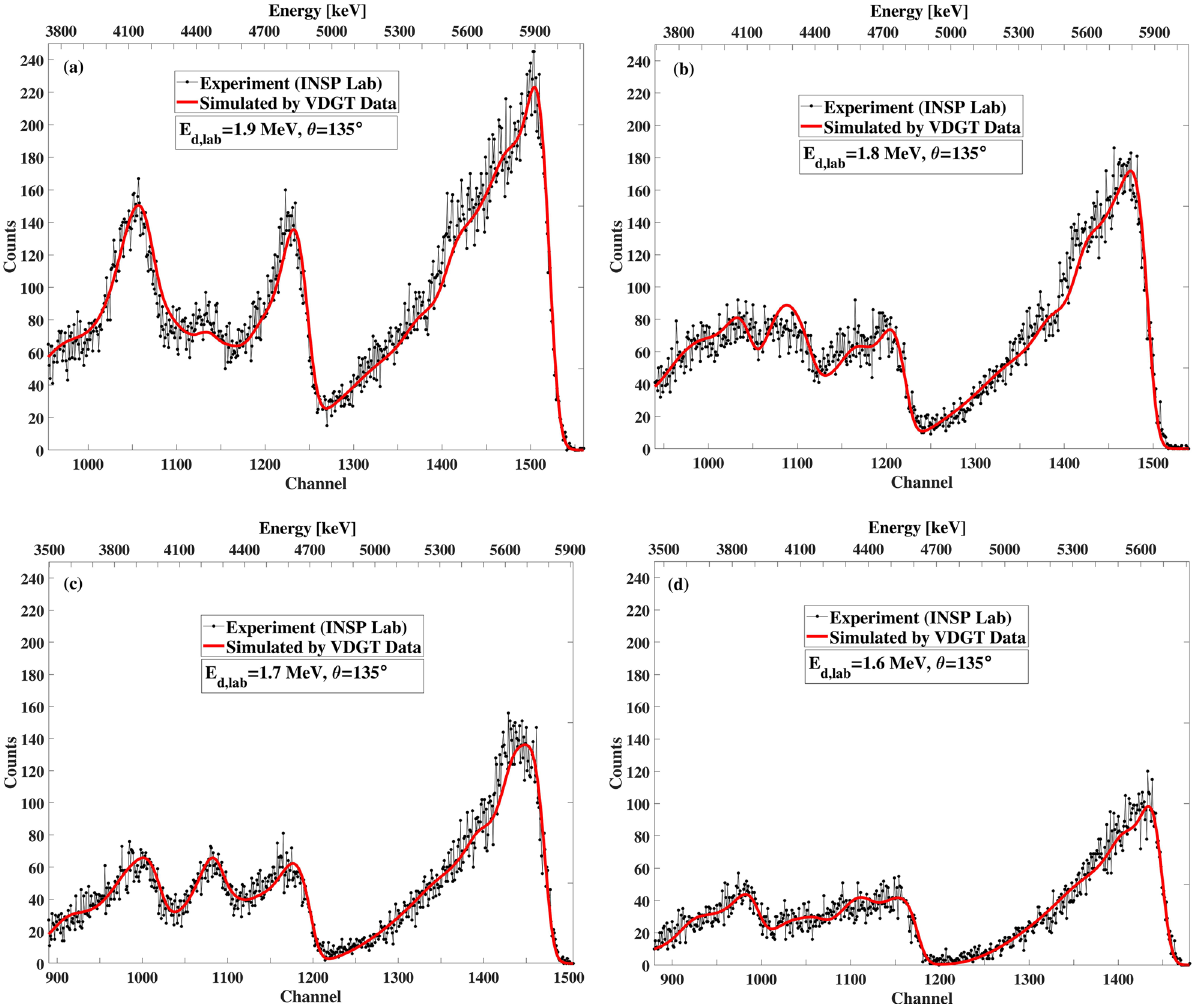
Figure 20. The benchmarking result at INSP Lab in Paris with measured VDGT data at 135° for different incident deuteron energies of ( a ) 1.9 MeV, ( b ) 1.8 MeV, ( c ) 1.7 MeV, ( d ) 1.6